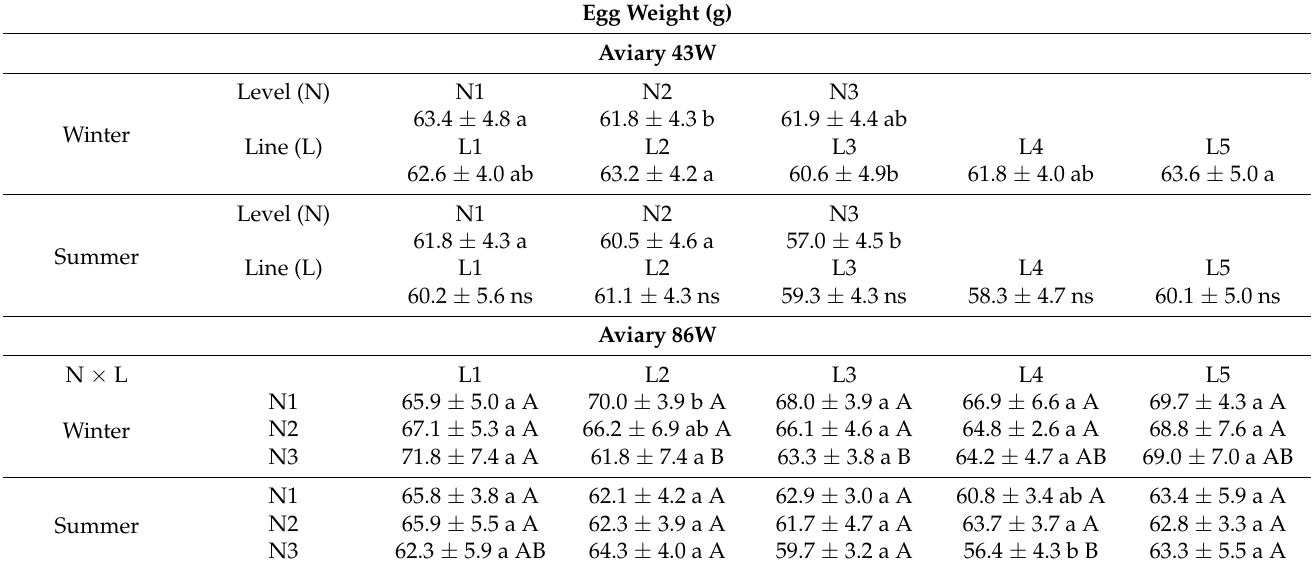
Table 5. Comparison between the mean egg weight (g) obtained in the 43W and 86W aviaries during the winter and summer seasons for the factors level (N) and line (L), as well as the N × L interaction. Egg Weight (g) Aviary